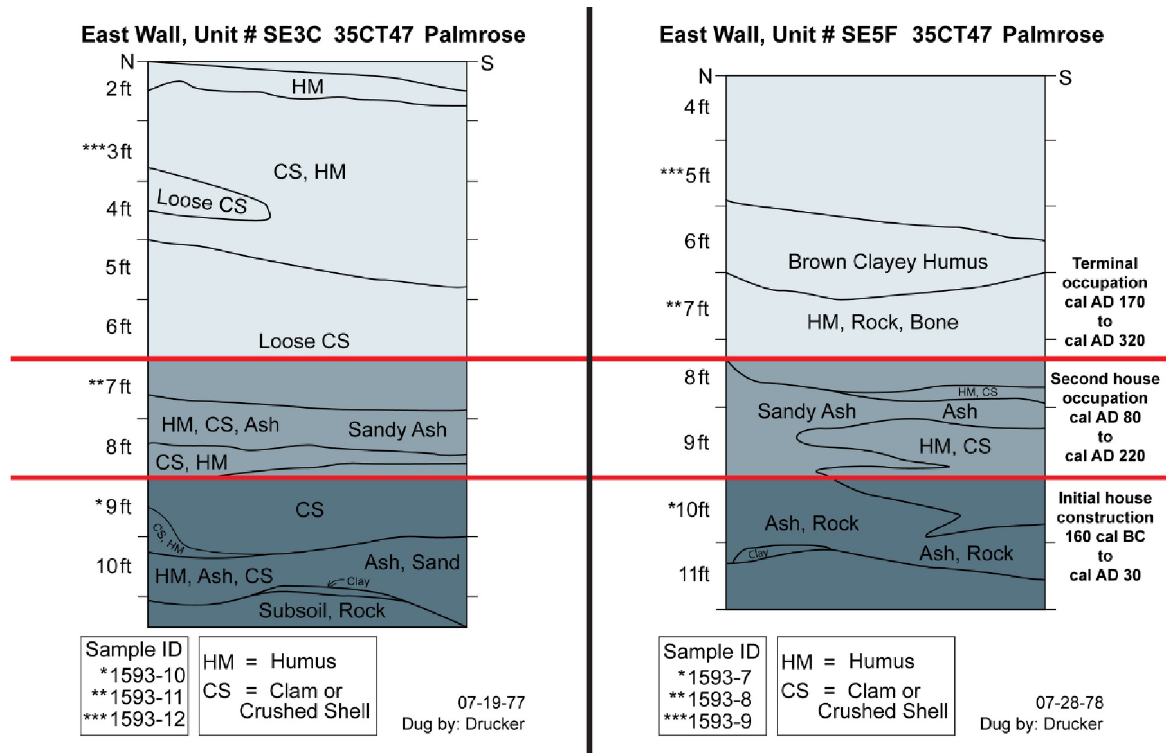
Fig 11. Unit SE3C and SE5F profiles with house occupation designations derived from reported stratigraphic data by Phebus and Drucker (40, 41).